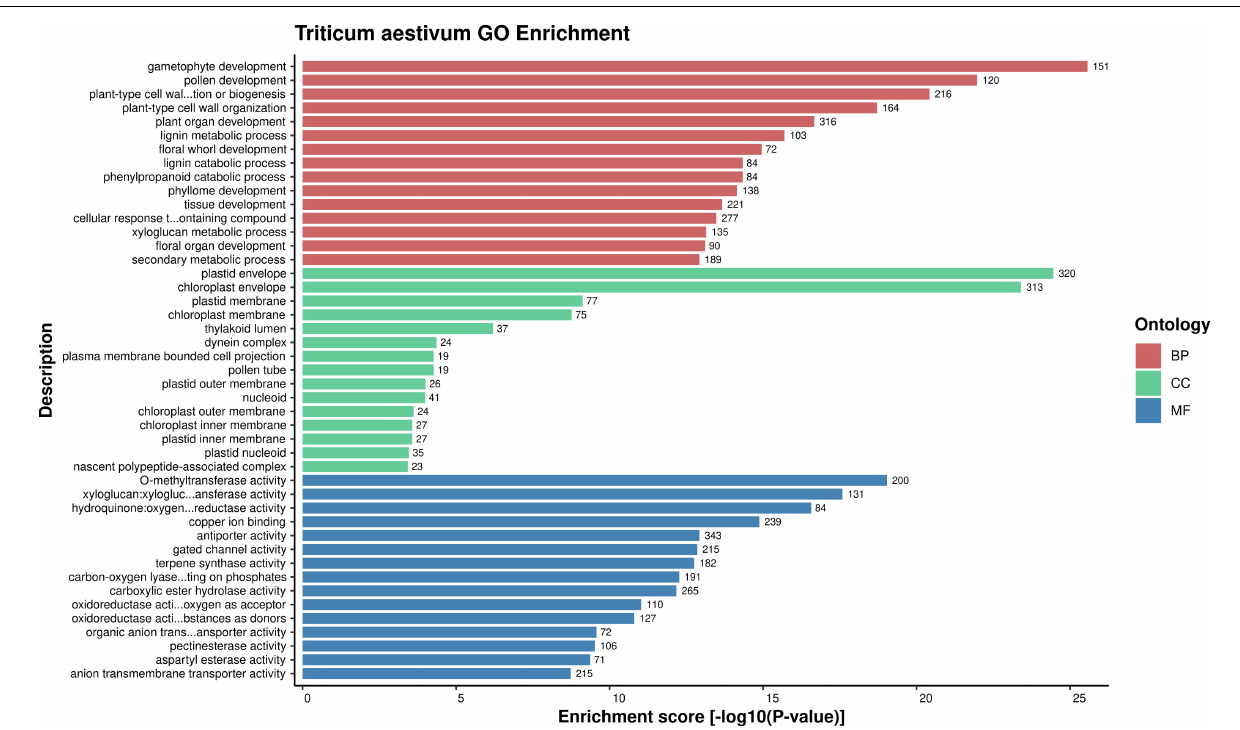
Kin1, GIN4, PASK, AMPK, CHK1, and MARK)